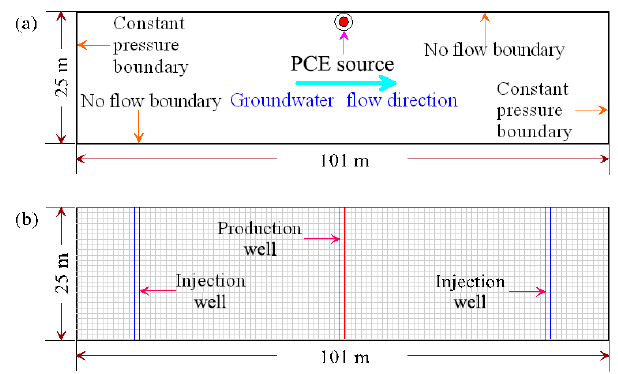
Figure 3. (a) Two-dimensional view of contaminated domain and (b) locations of injection and extraction wells.